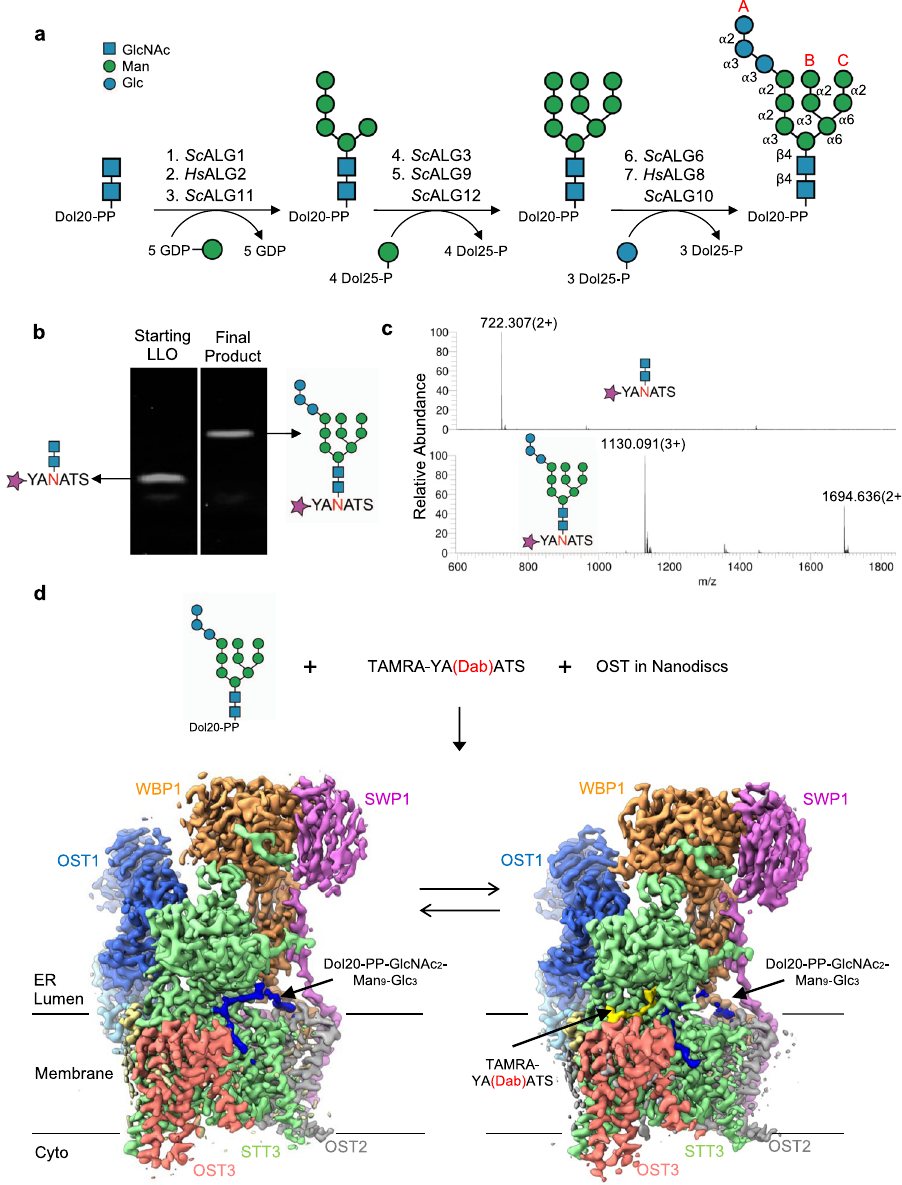
Fig. 1 | DonorLLOgenerationand cryo-EMstructuresofyeast OST withbound substrates. a Schematic of the chemo-enzymatic synthesis of Dol20-PP- GlcNAc 2 Man 9 Glc 3 . Branches A, B, and C are labeled in the fi nal product and gly- cosidic linkages are indicated. Enzyme names above reaction arrows denote pur- i fi ed ALG proteins. b Representative tricine-SDS-PAGE analysis of fl uorescently lapeledpeptideTAMRA-YANATS-NH 2 glycosylatedinvitrousingpuri fi edyeastOST and either Dol20-PP-GlcNAc 2 or the fi nal product Dol20-PP-GlcNAc 2 Man 9 Glc 3 .